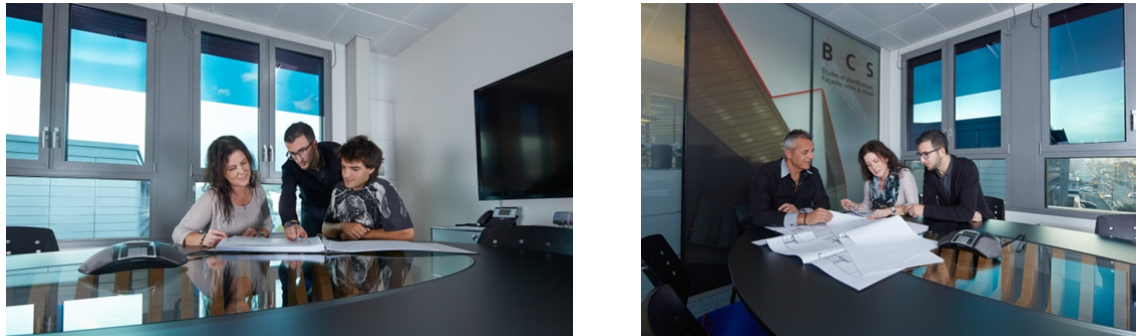
Fig. 12 Offices in Neuchatel equipped with EC glass and in-pane zoning. The upper zone is in the fully tinted state to black glare while the lower zone is in the clear state to admit sufficient daylight. Views to outdoors are maintained all the time. © Vetrotech